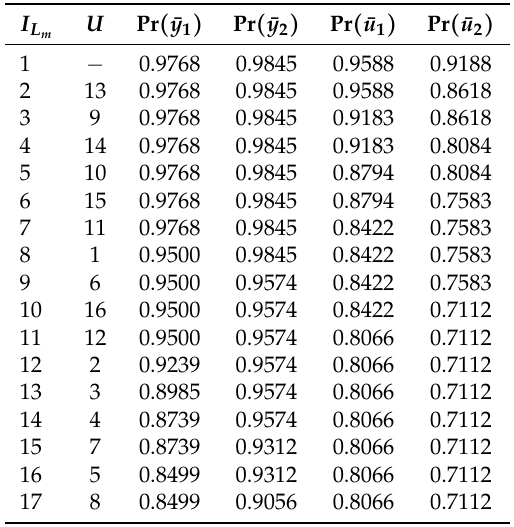
Table 7. Probabilities of successful transmission for each new setting of the network such that the nodes U exchange L 8,5 following the sequence I Lm (Mixed ∈ { }